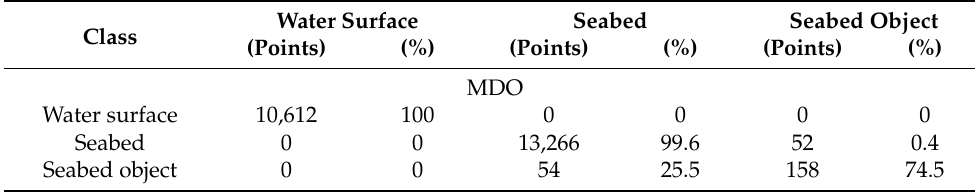
Table 7. Confusion matrix of median results for algorithm